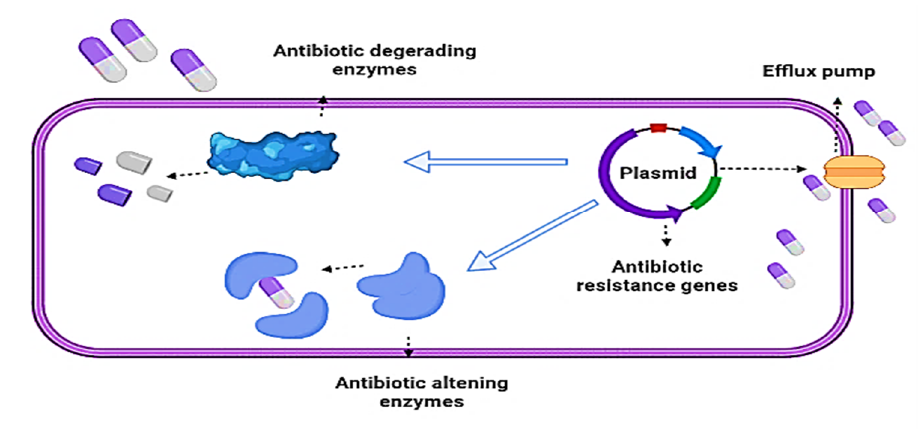
Figure 1. Mechanism of bacterial resistance to